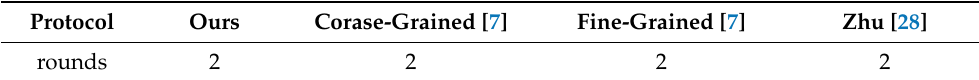
Table 2. Comparison of communication